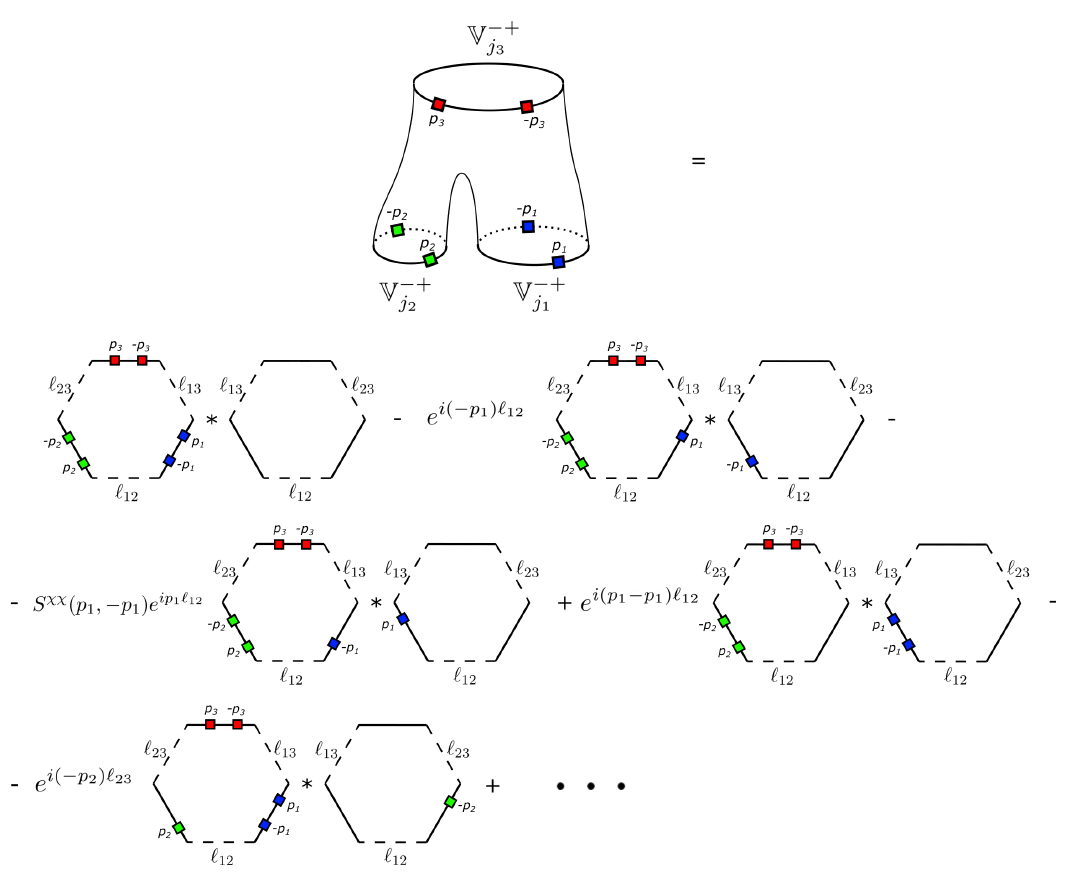
Figure 6 . We represent schematically some of the terms contributing to the hexagon computation of the three-point function. We cut the three-point functions in two hexagons, one corresponding to the “front” of it and one to the “back” (the cut runs parallel to the surface of the page). Then, we have to sum over all possible ways of distributing each pair of particles over the two patches, for a total of (2 2 ) 3 = 64 possibilities; in the figure we only write the first 2 2 = 4 terms relative to moving around { p (in blue), and one term relative to moving { p (in green). The 1 , − p 1 } 2 , − p 2 } various terms have to be weighted as in eq.